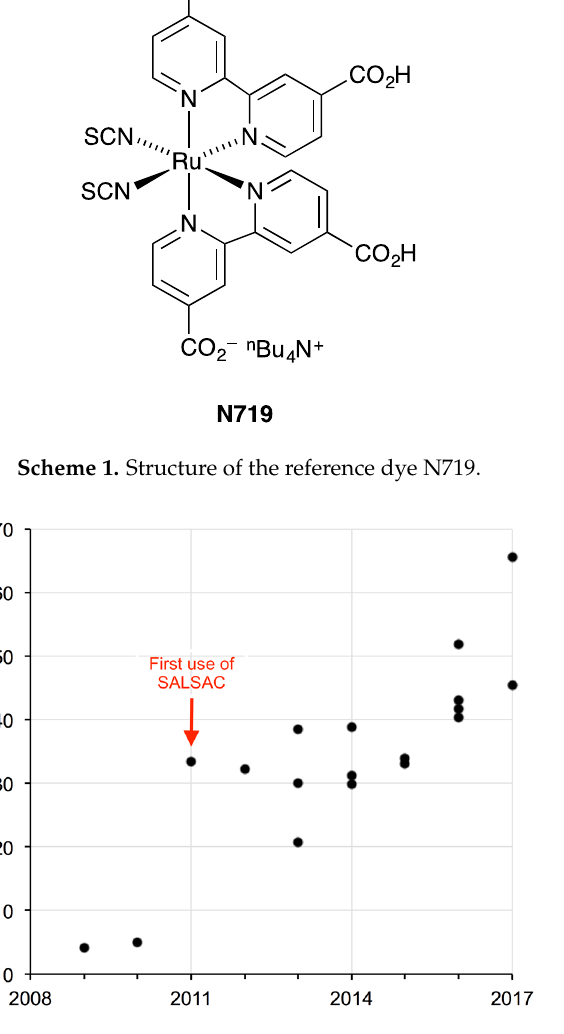
Figure 1. Progress of our own work in dye-sensitized solar cells (DSSCs) with copper(I) dyes presented in terms of photoconversion efficiencies relative to N719 set at 100%. Data points are chosen for the best performing cells reported each year.